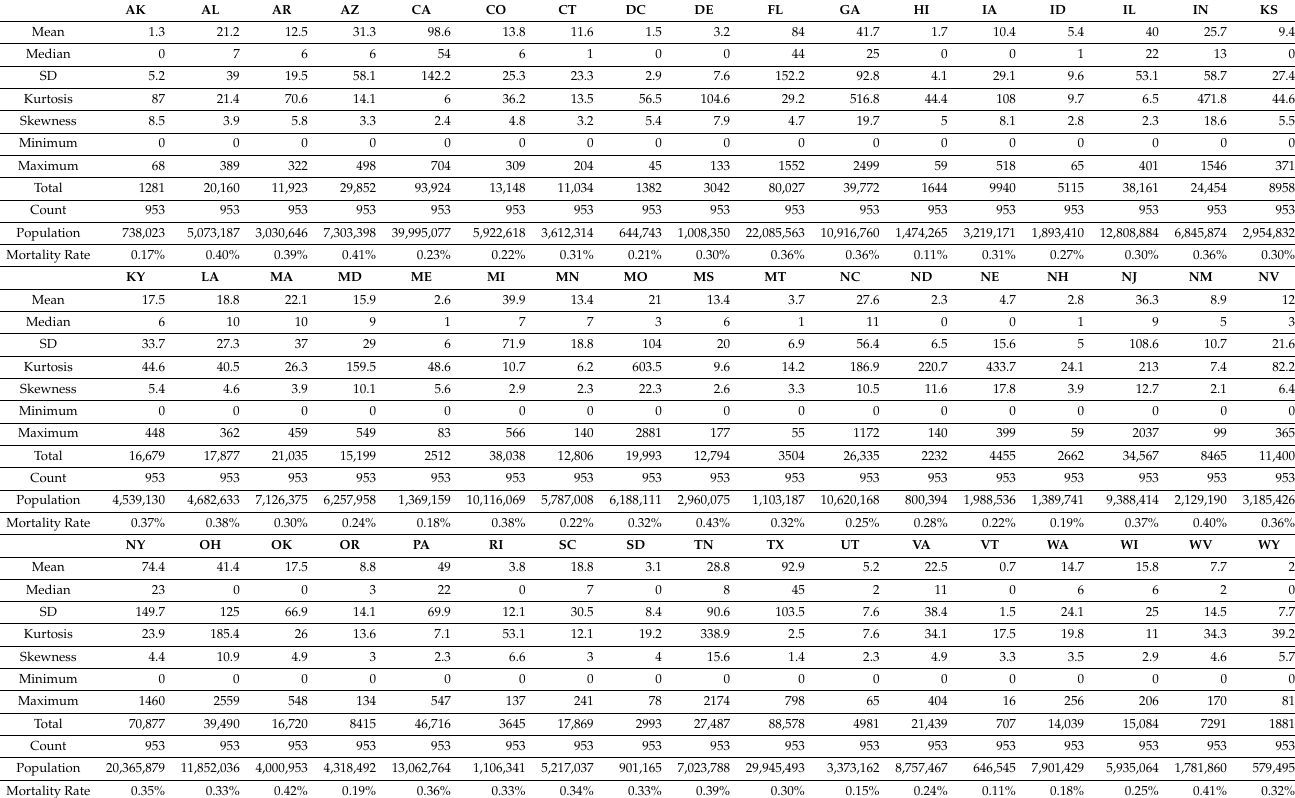
Table 1. Summary Statistics for US Daily COVID-19 Mortalities and 2022 US State